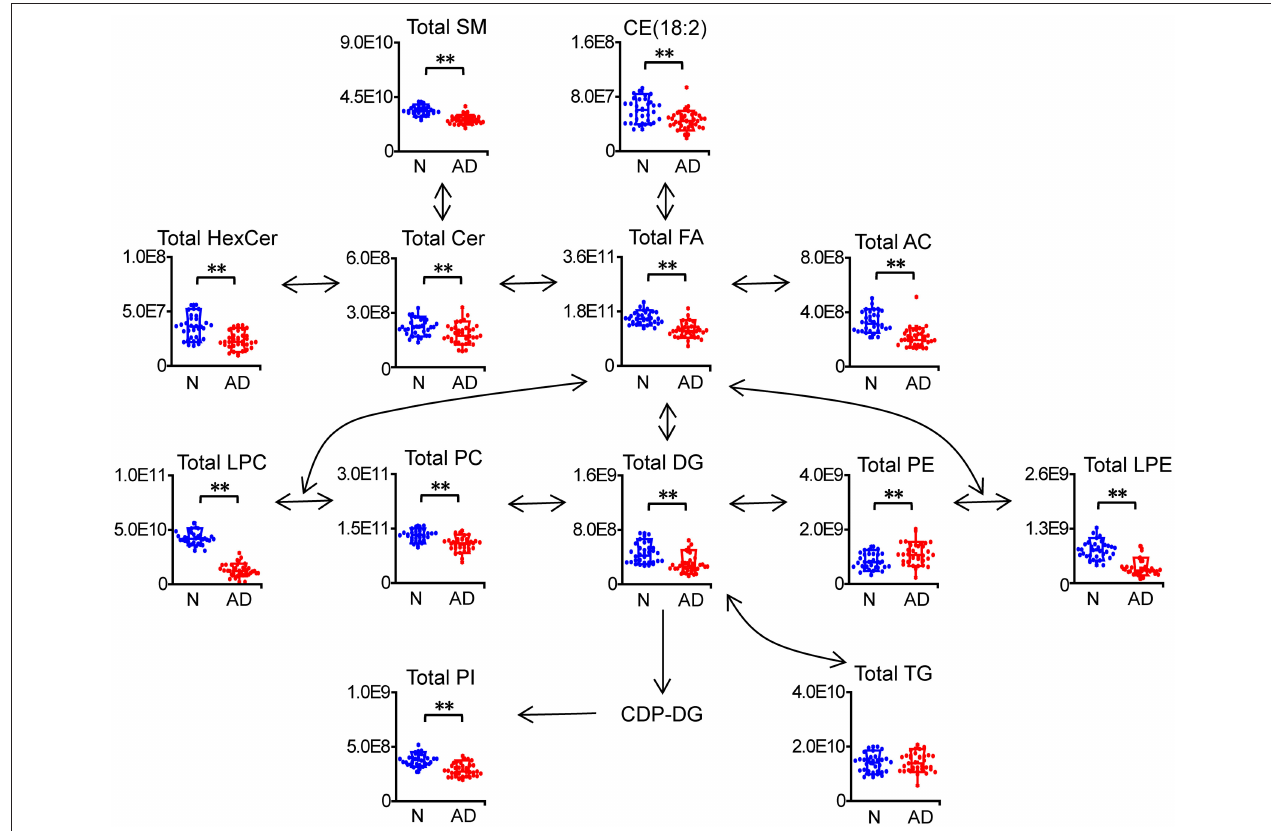
FIGURE 3 | Characteristic changes in total lipids of each category in patients with AD. n = 32 and 35 in the normal (N) and AD group, respectively. ** P < 0.01, two-tailed Mann-Whitney U test. The relative abundances of lipids were used for the box plot. Arrows indicate the conversion between lipids. FA, fatty acid; AC, acyl carnitine; CE, cholesteryl ester; Cer, ceramide; HexCer, hexosylceramide; SM, sphingomyelin; LPC, lysophosphatidylcholine; LPE, lysophosphatidylethanolamine; PC, phosphatidylcholine; PE, phosphatidylethanolamine; PI, phosphatidylinositol; DG, diglyceride; TG, triglyceride.